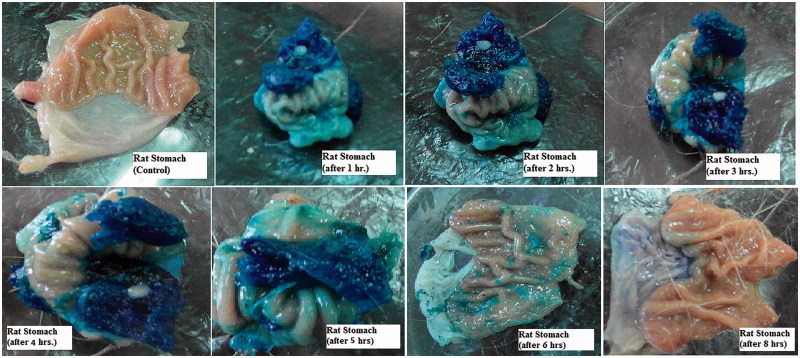
Light photos showing presence of gels in rat stomach at different time intervals after oral administration of optimized formula.